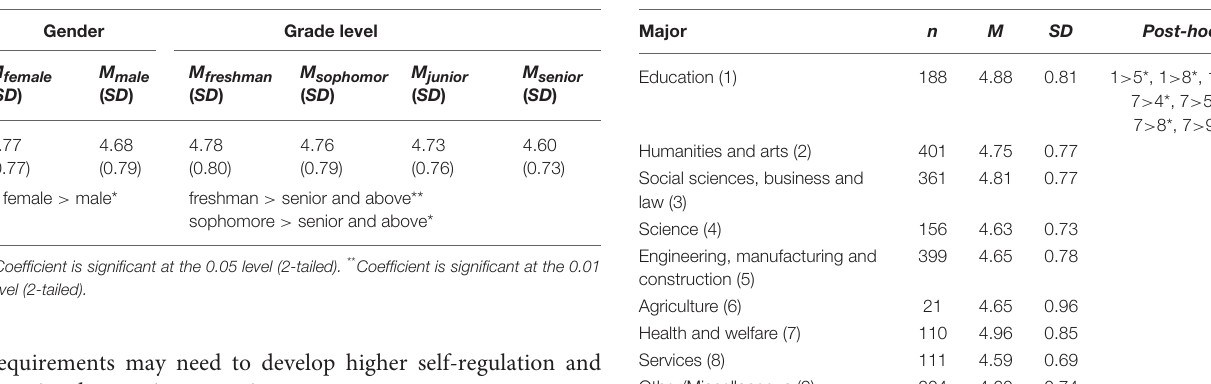
TABLE 9 | Post-hoc (Bonferroni) analyses among